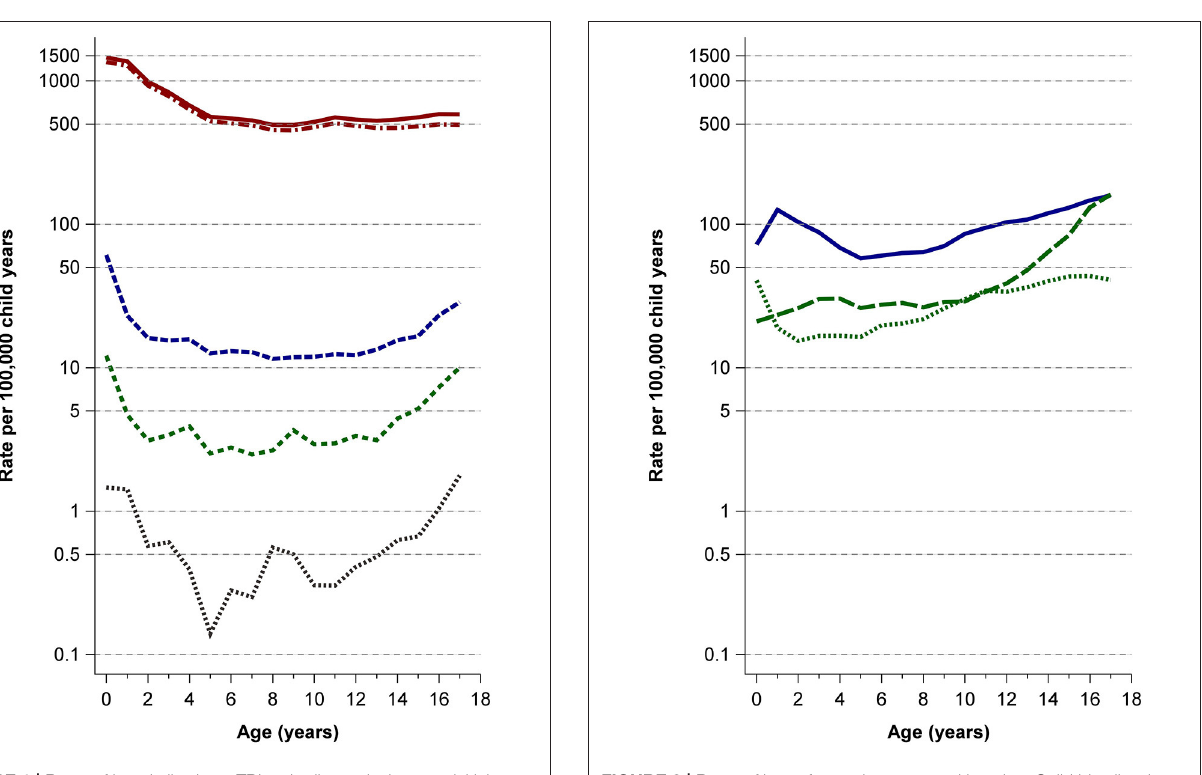
FIGURE 1 | Rates of hospitalizations, TBI main diagnosis, intracranial injury, neurosurgery, and mortality. Solid red line : hospitalizations with TBI; dash-dotted red line : TBI main diagnosis; medium-dashed blue line : intracranial injury; short-dashed green line : neurosurgery; dotted black line : mortality.